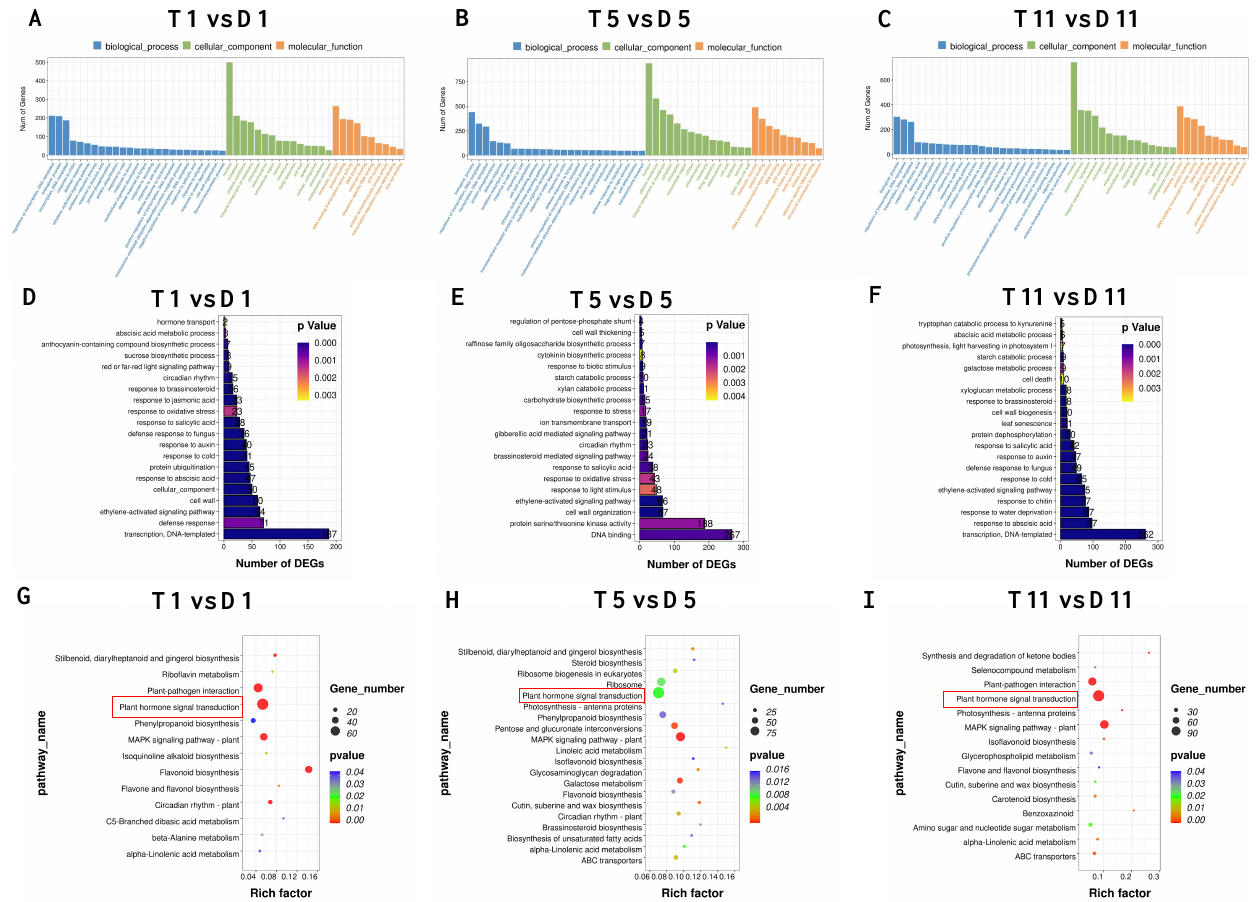
Figure 3. Functional enrichment analysis of differentially expressed genes (DEGs) between diploid and tetraploid poplar 84K. ( A – C ) Gene ontology (GO) analysis of DEGs in the first leaf ( A ), fifth leaf ( B ), and 11th leaf ( C ). ( D – F ) The 20 most enriched biological process GO terms in the first leaf ( D ), fifth leaf ( E ), and 11th leaf ( F ). ( G – I ) Kyoto Encyclopedia of Genes and Genomes (KEGG) analysis of enriched pathways among DEGs in the first leaf ( G ), fifth leaf ( H ), and 11th leaf ( I